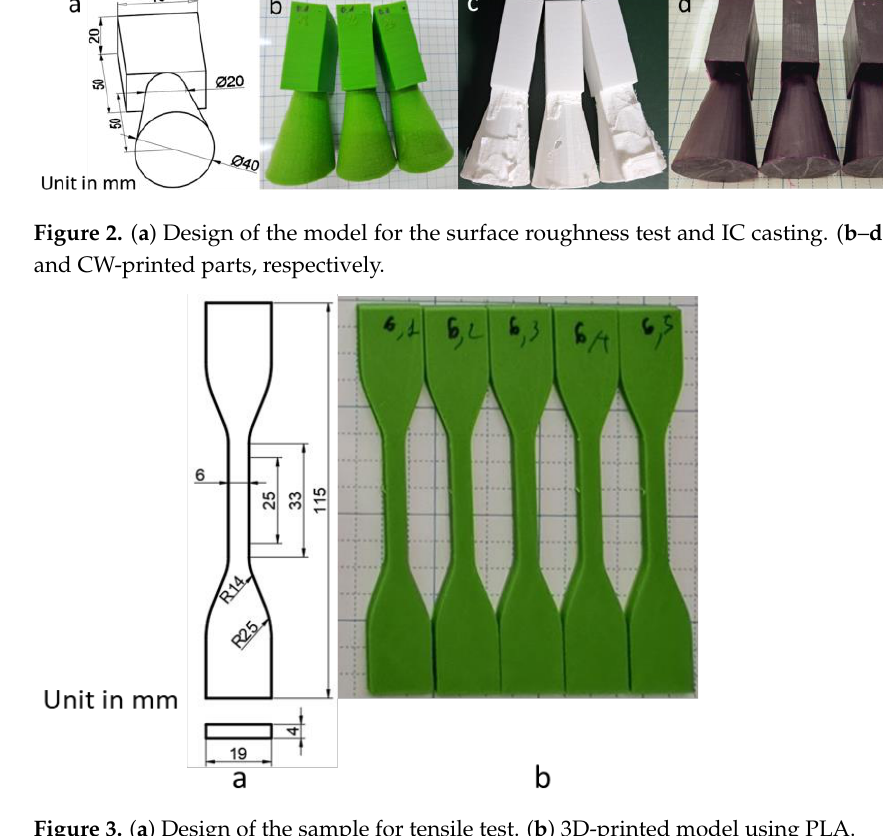
Figure 3. ( a ) Design of the sample for tensile test. ( b ) 3D – printed model using PLA.